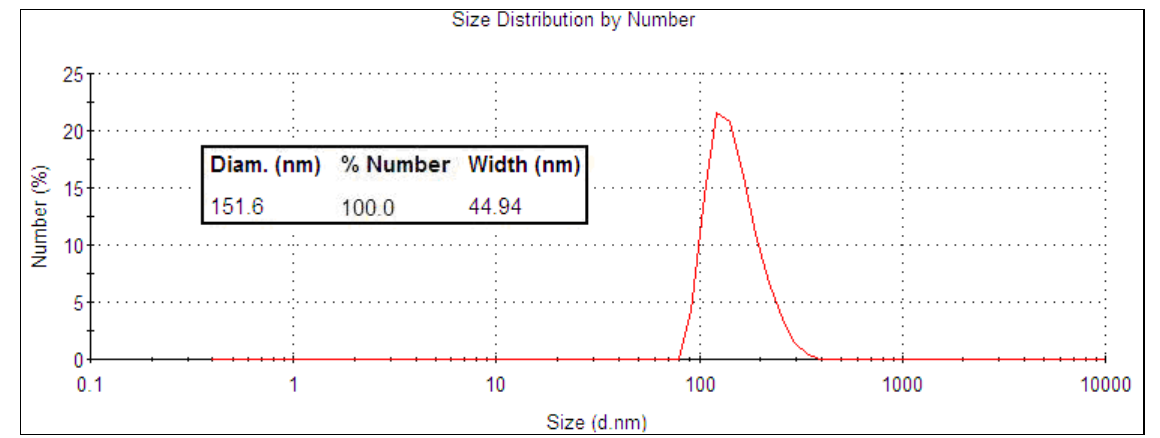
Figure 6. DLS size distribution data of Auroshell®